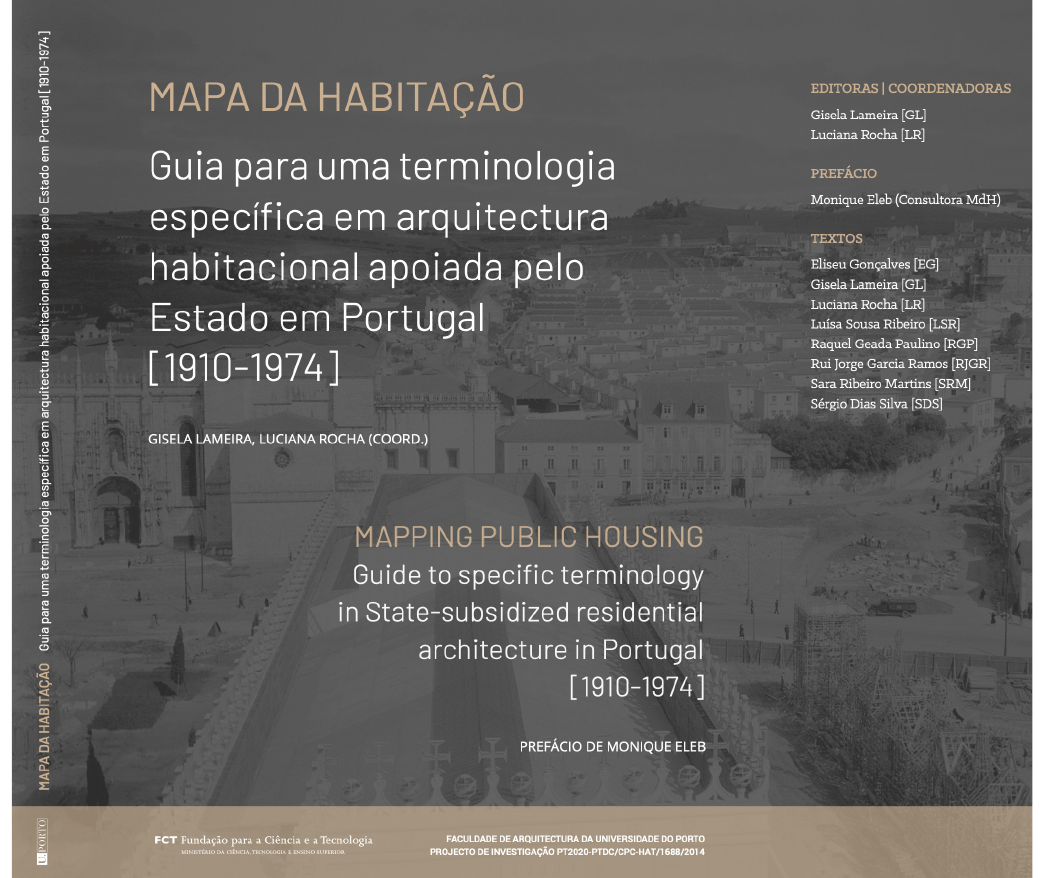
Figure 1. Cover of the printed edition of the Guide to Specific Terminology in State‐Subsidized Residential Architecture in Portugal [1910–1974] . Source: Lameira and Rocha